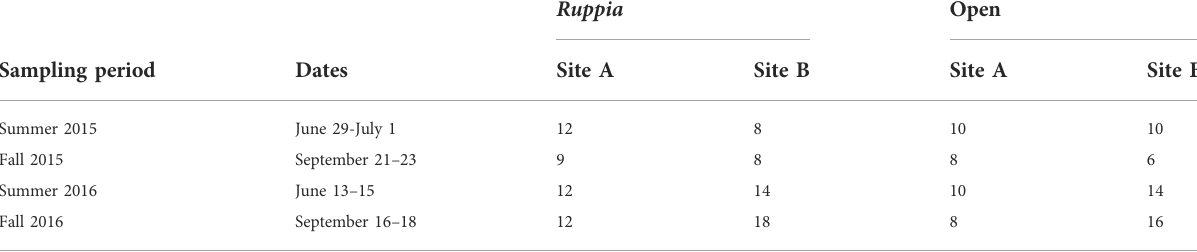
TABLE 1 Sampling periods, dates, and sample sizes for Ruppia and unvegetated ( ‘ open ’ ) habitats at Site A (unoiled) and Site B (oiled).